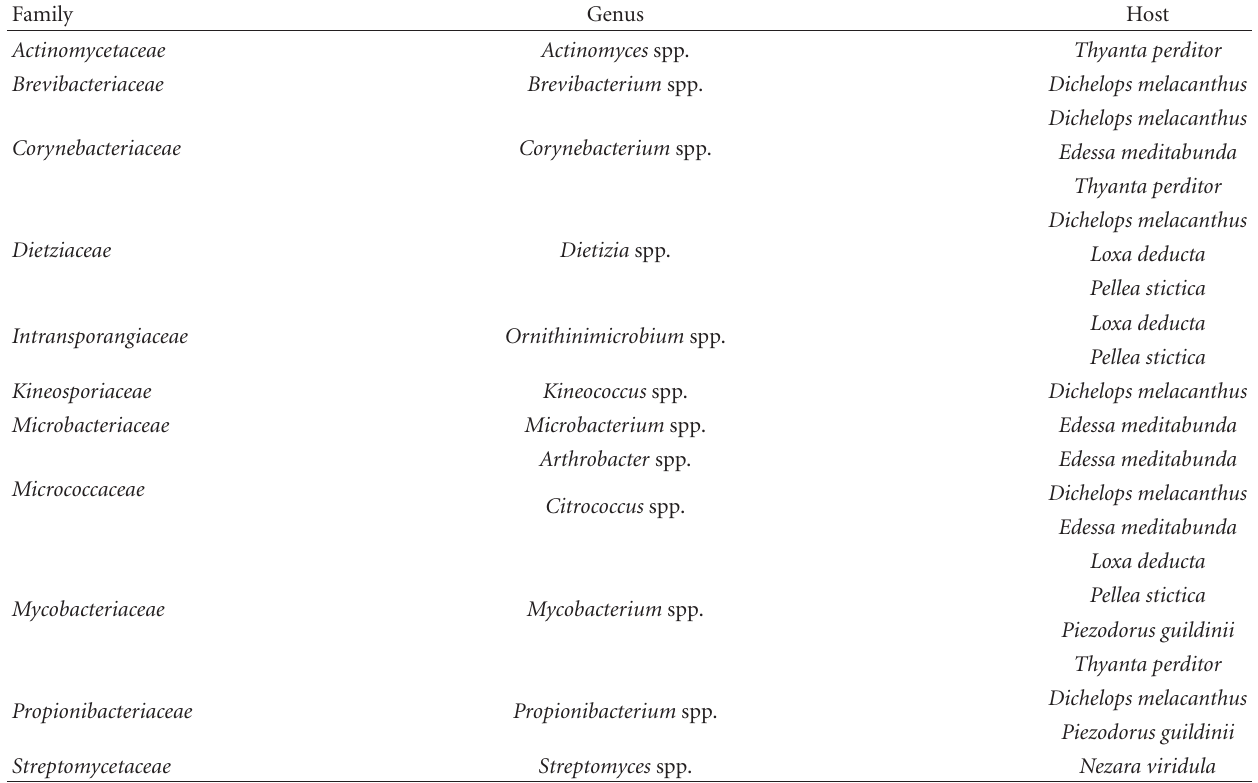
Table 1: Actinobacteria diversity inhabiting the midgut of